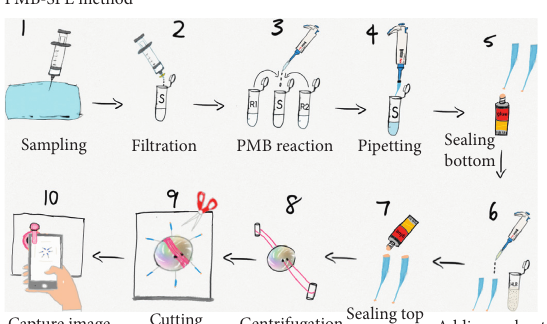
Figure 2: Schematic illustration of field preconcentration and digital image colorimetric sensing of phosphate. The description is detailed in Section 2.3.